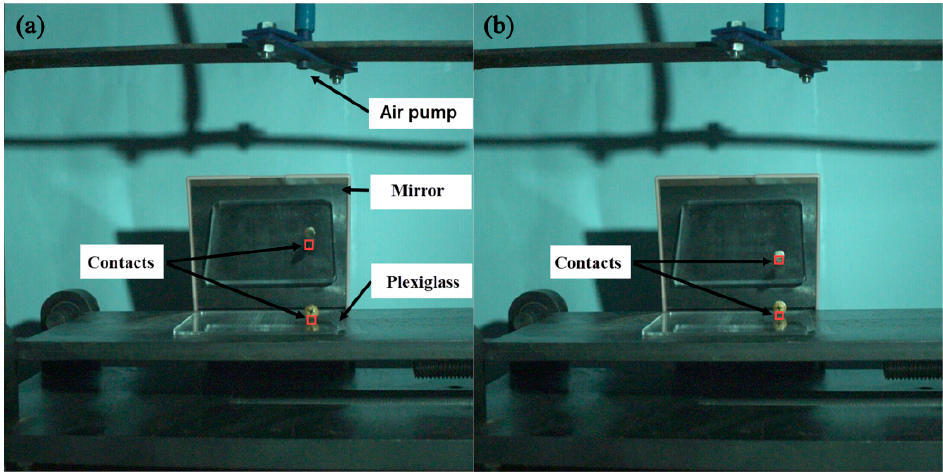
Figure 1. Measurement of the coefficient of restitution between seed particles and boundaries: ( a ) the first collision and ( b ) Second collision.